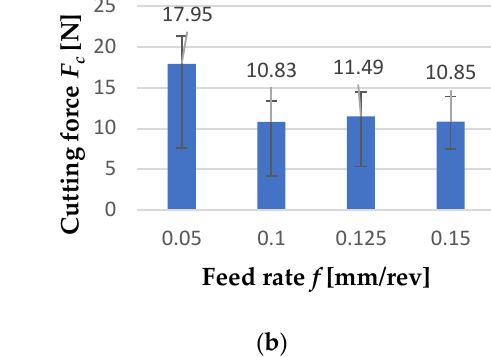
Figure 18. The graphs include results of forces measurements of turning of: ( a ) FEPA 046 shaft and ( b ) FEPA 100 shaft (exact values are given above the bars).